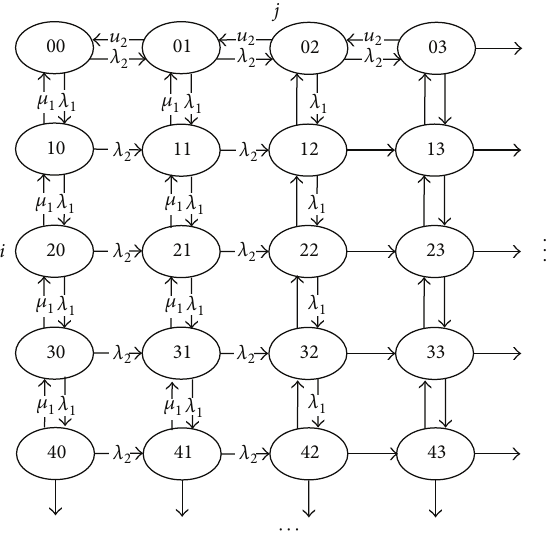
Figure 5: System state spaces and the transfer